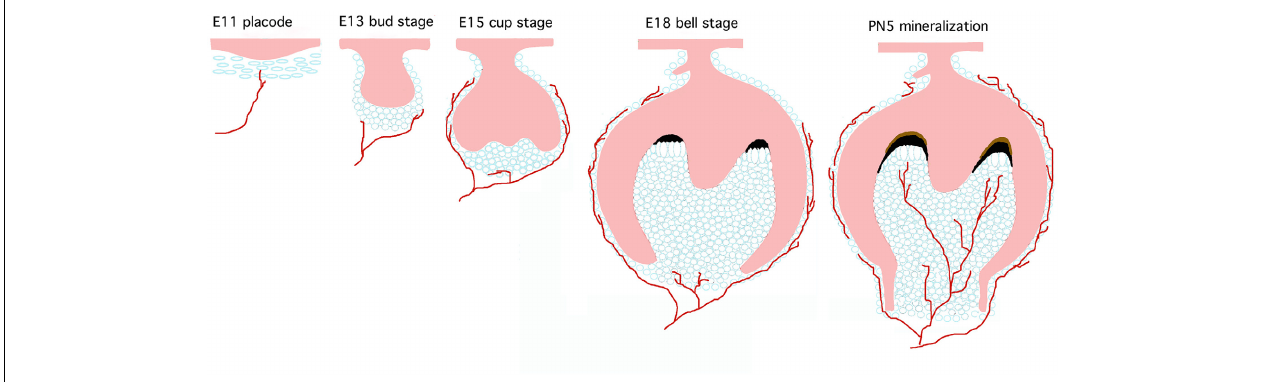
FIGURE 1 | Mouse tooth development and innervation. Teeth develop through continuous interactions between dental epithelium (pink) and neural crest-derived mesenchyme (light blue). Axons from the trigeminal nerve